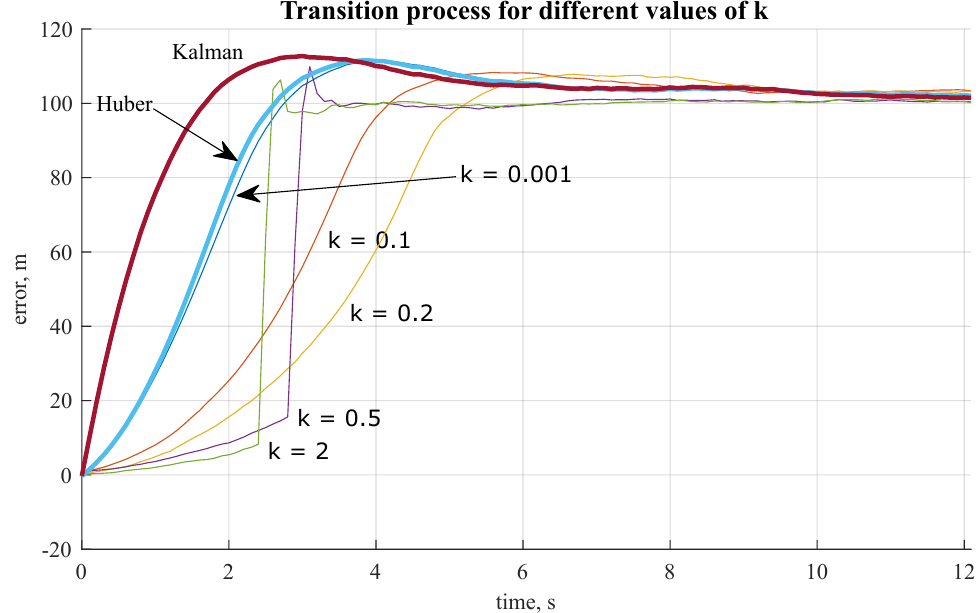
Figure 7. Filter response to step measurements. «Robust»—the proposed robust algorithm. «Huber»—M score.